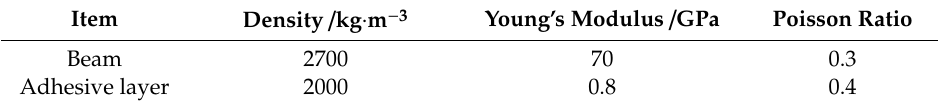
Table 2. Material coefficients of the beam and the adhesive layer.